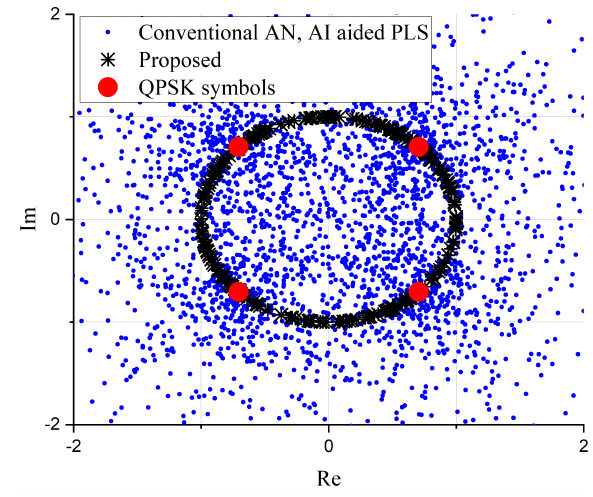
Figure 1. Signal constellation comparison at the